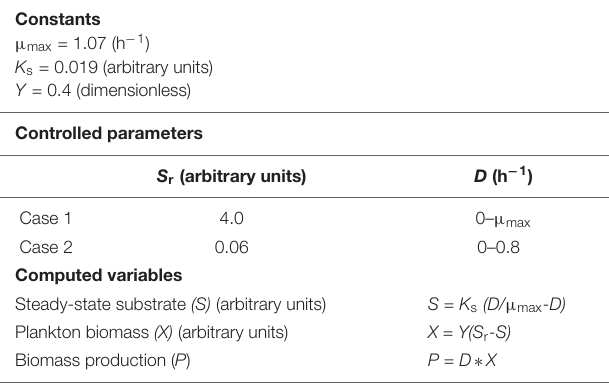
TABLE 1 | Kinetics of the chemostat model based on Enterococcus faecalis